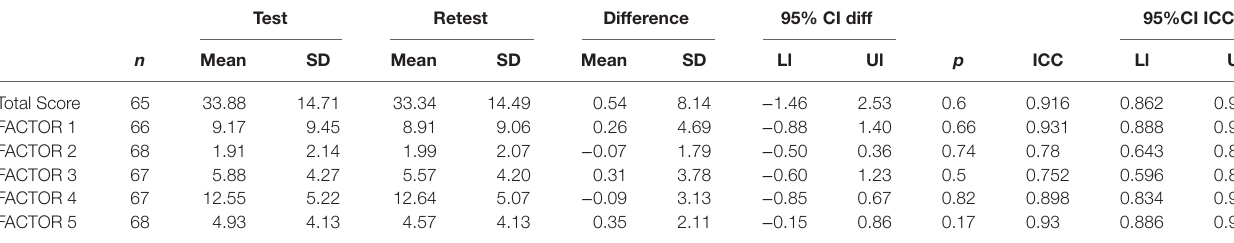
tAble 4 | Average test and retest scores, difference, and ICC. test Retest difference 95% CI diff 95%CI ICC